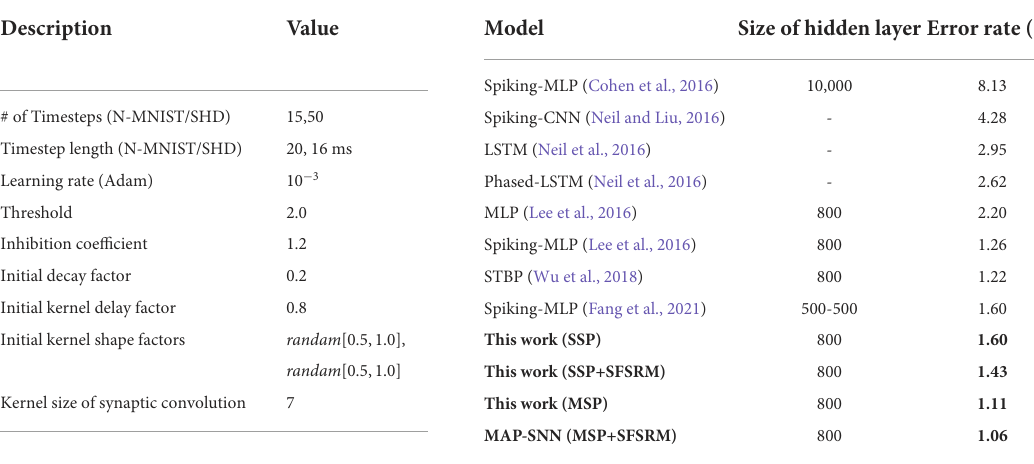
TABLE 1 Hyperparameters setting. TABLE 2 Performance of different algorithms on N-MNIST.